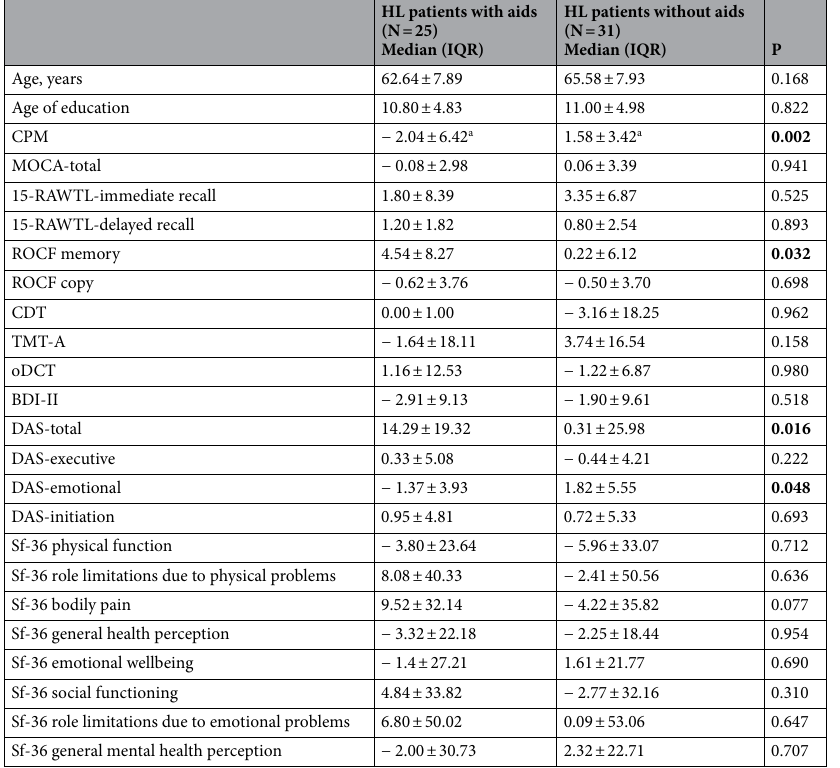
Table 2. Delta (T 1 – T 0 ) values for neuropsychological and behavioral variables in HL patients with and without hearing aids. Statistically significant differences are indicated in bold. 15-RAWLT Rey’sauditory 15-word learning test- Verbal immediate recall; 15-RAWLT, Rey’sauditory 15-word learning test- Verbal delayed recall; BDI-II, Beck Depression Inventory II; CDT, Clock Drawing Test; CPM, Raven’s Coloured Progressive Matrices; DAS, DimensionalApathy Scale; HL, hearing loss; IQR, Interquartile ranges; MOCA, Montreal Cognitive Assessment; N, simplesize;oDCT, DigitCancellation Test; ROCF, Rey-OsterriethComplex Figure Test;; SF 36, Short form 36; T 0 = base-line; T 1 = Follow up; TMT-A, TrailMaking Test Part A. a HL patients with aids vs HL patients without aids, corrected for p ≤ 0.0125.